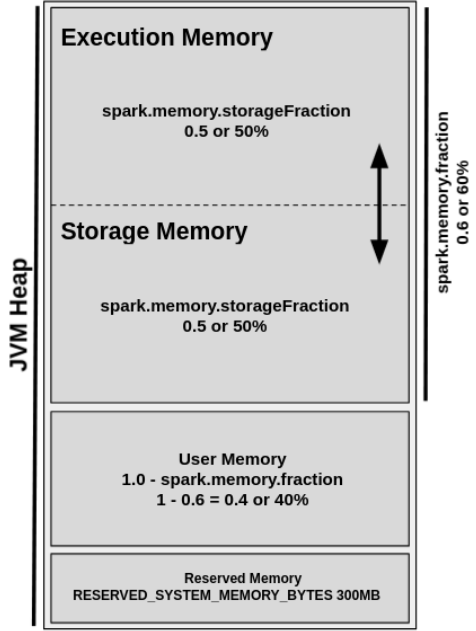
Figure 3. Unified Memory